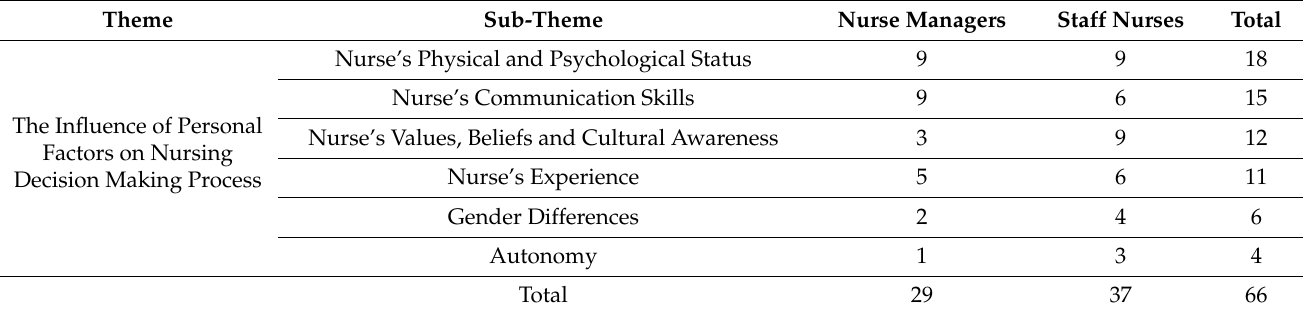
Table 1. Comparison of personal factors’ effect on decision-making process between nurse managers and staff nurses. Theme Sub-Theme Nurse Managers Staff Nurses Total